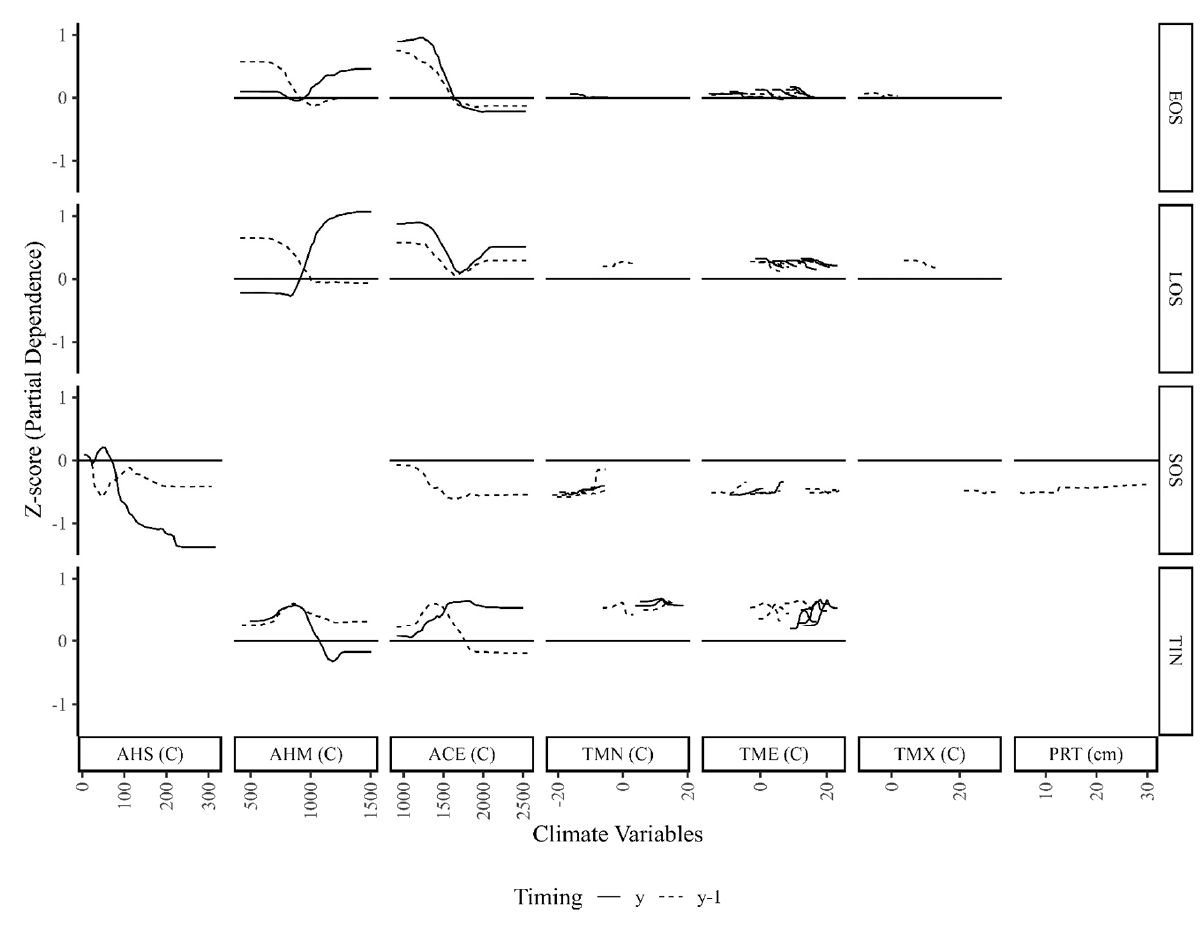
Figure 3. Partial dependence plots of important variables used in the final RF (Random Forest) models. Partial dependence (i.e., the marginal influence of a given variable with the effect of all other variables averaged out but not ignored) plots are grouped by variable class, and variables are divided by time (y = current, y − 1 = lagged). For plots with no lines, the corresponding variables were not ranked as important by preliminary RF models and were therefore not included in the final RF models. Forest growth indices: TIN = time-integrated NDVI; LOS = length of growing season; SOS = start of growing season; EOS = end of growing season. Climatic variables: AHS = accumulated heating (SOS); AHM = accumulated heating; ACE = accumulated chilling; TMX, TME, and TMN = maximum, mean and minimum temperature; PRT = precipitation.